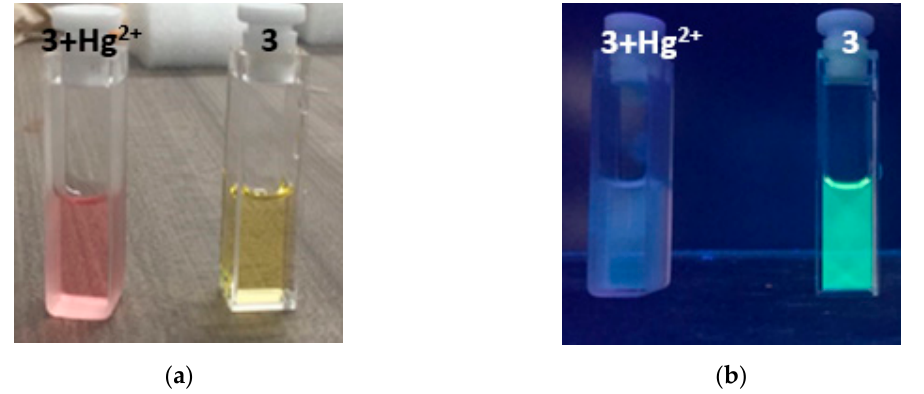
Figure 7. ( a ) Colorimetric change of compound 3 in the presence of mercuric ions; ( b ) fluorimetric change of compound 3 in the presence of mercuric ions.